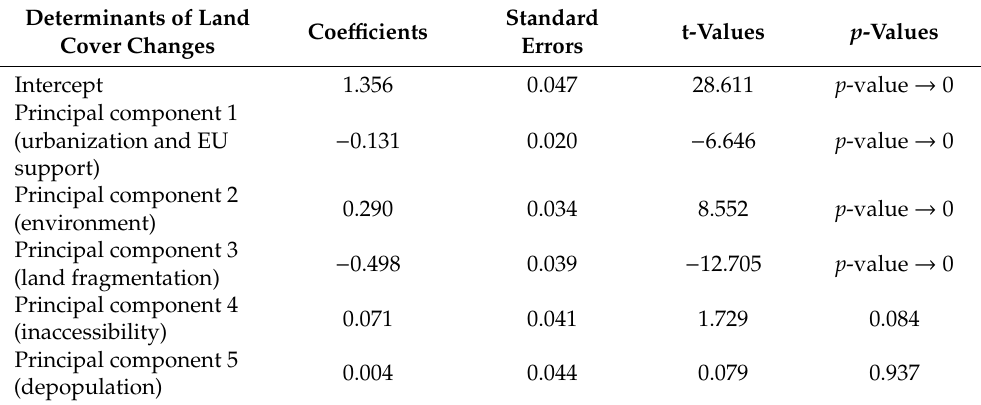
Table 3. Global model estimating land cover changes in Poland, in the years 2012–2018.